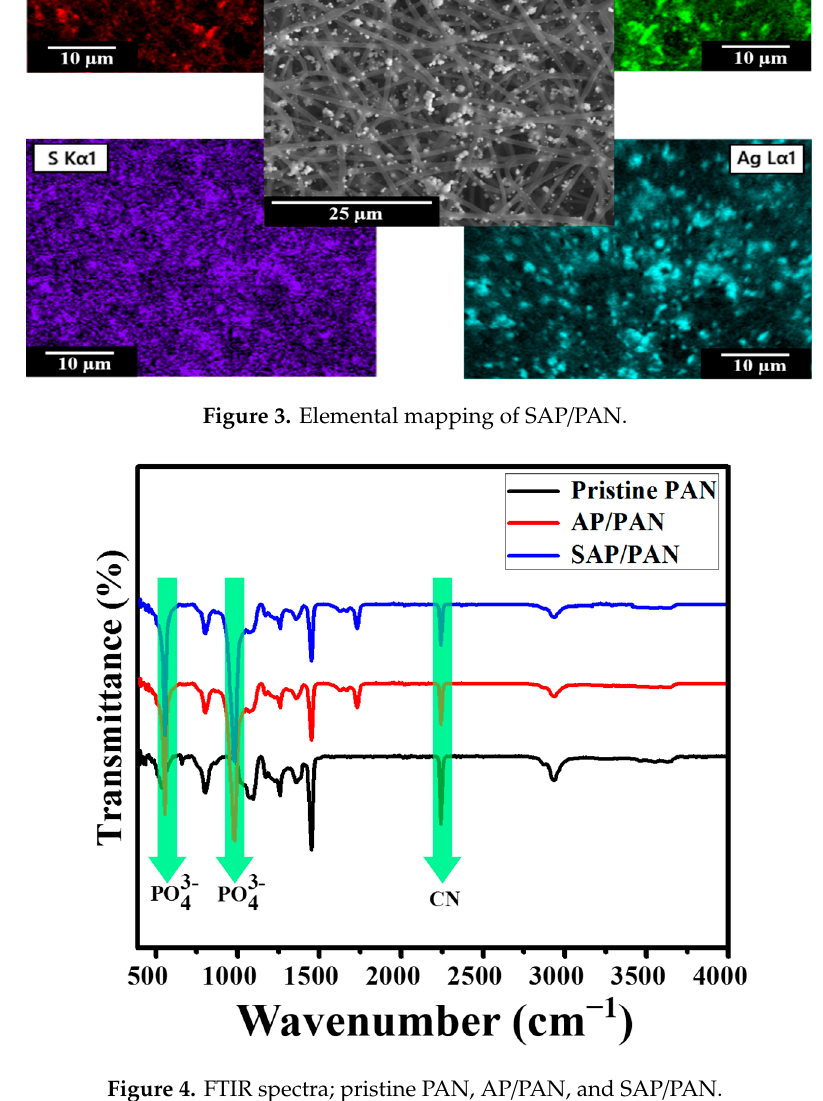
/ PAN, and SAP / Figure 4. FTIR spectra; pristine PAN, AP/PAN, and SAP/PAN. Figure 4. FTIR spectra; pristine PAN, AP Figure 4. FTIR spectra; pristine PAN, AP/PAN, and SAP/PAN.